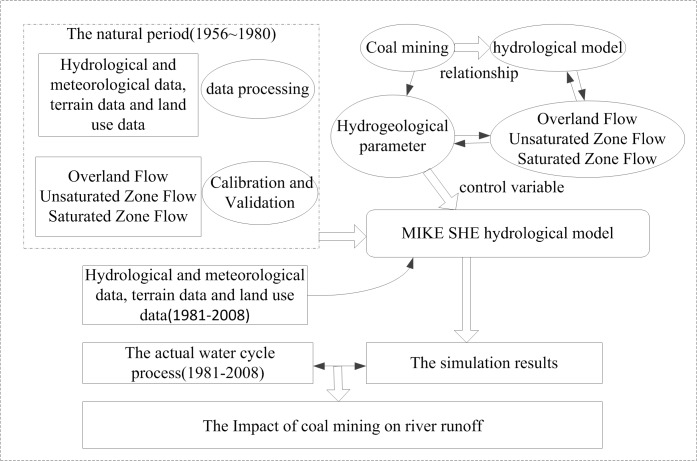
Technology roadmap.